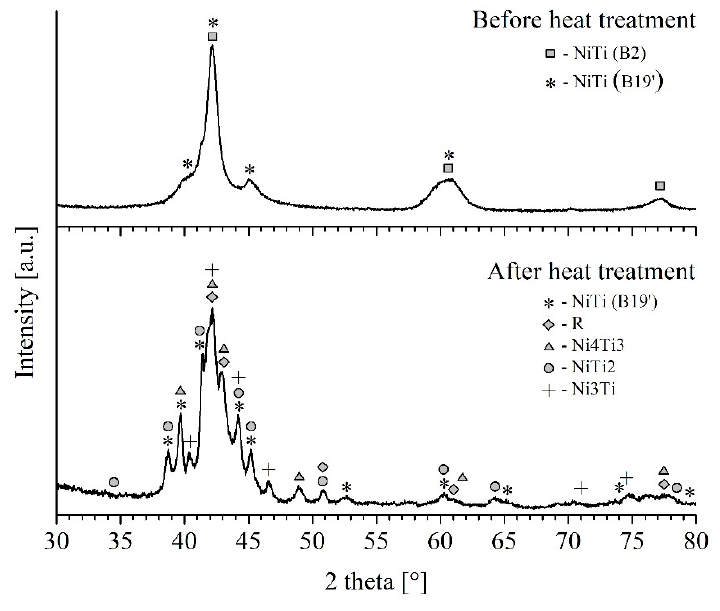
Figure 9. X-ray diffraction pattern before and after heat treatment.